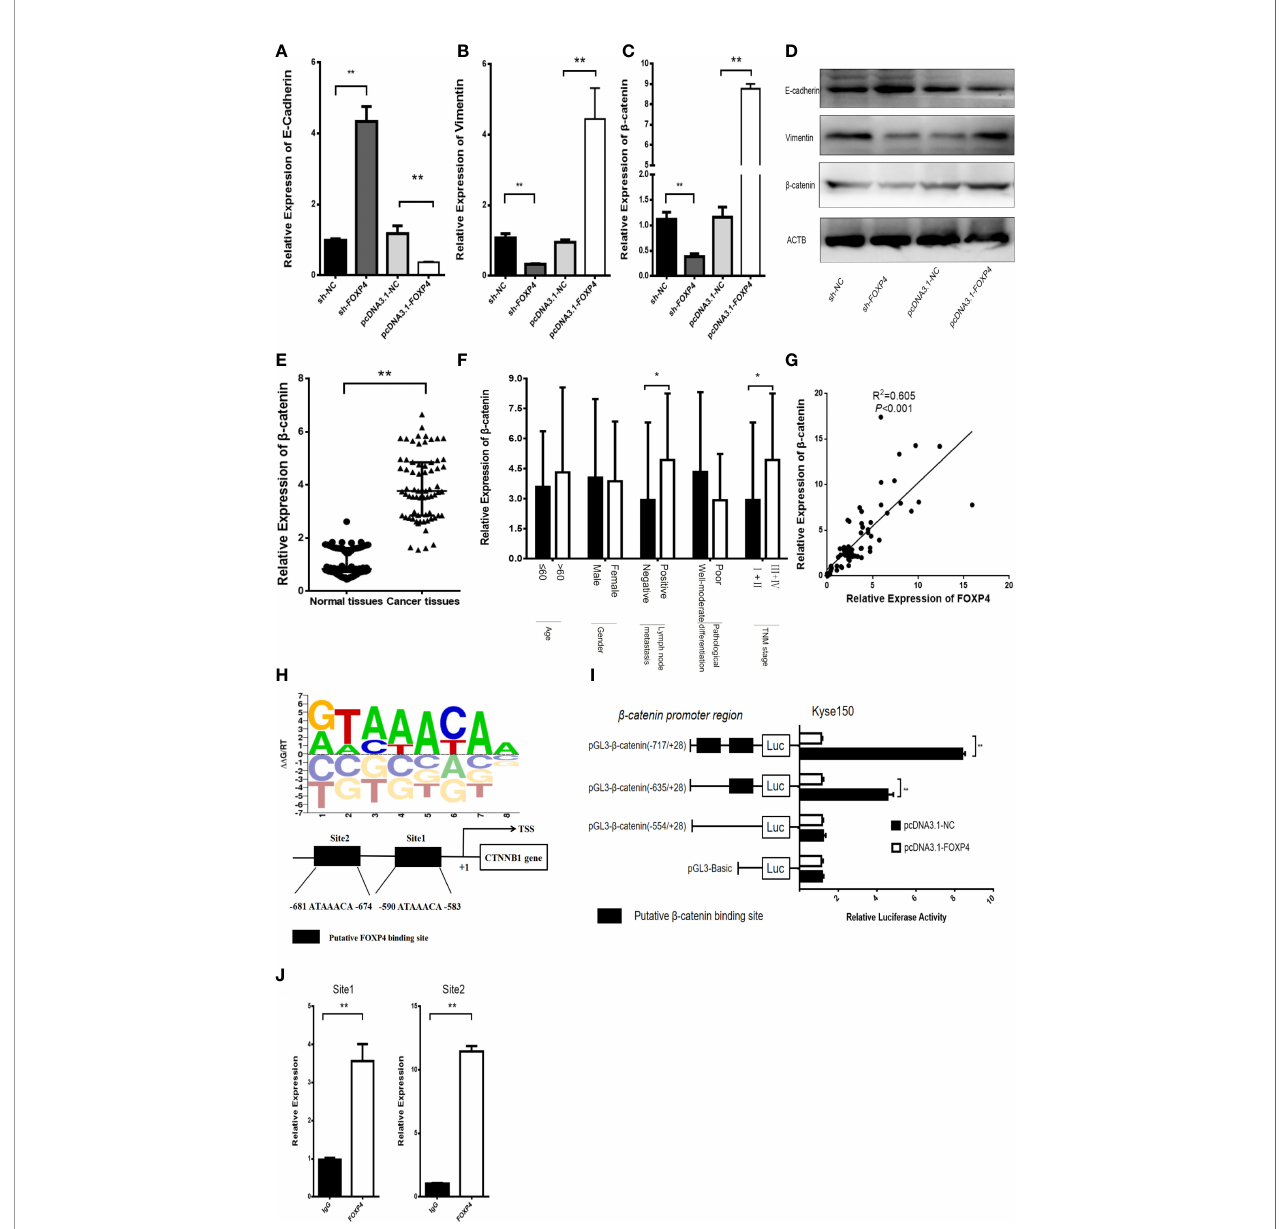
FIGURE 6 | FOXP4 regulates b -catenin expression as a transcription factor. The mRNA (A, B, C) and protein (D) levels of EMT ‐ related genes (E ‐ cadherin, b -catenin, and Vimentin) with sh ‐ FOXP4 or pcDNA3.1-FOXP4 by qRT – PCR or WB. The expression of b -catenin in ESCC (E) and different subgroups (F) by qRT – PCR. (G) The correlation between FOXP4 and b -catenin by qRT – PCR. (H) The predicted FOXP4 binding site sequence in the promoter of b -catenin. (I) The effect of FOXP4 on the luciferase activity of b -catenin by dual-luciferase reporter assay. (J) The direct interaction of FOXP4 with the b -catenin promoter by ChIP. * p < .05 and ** p <